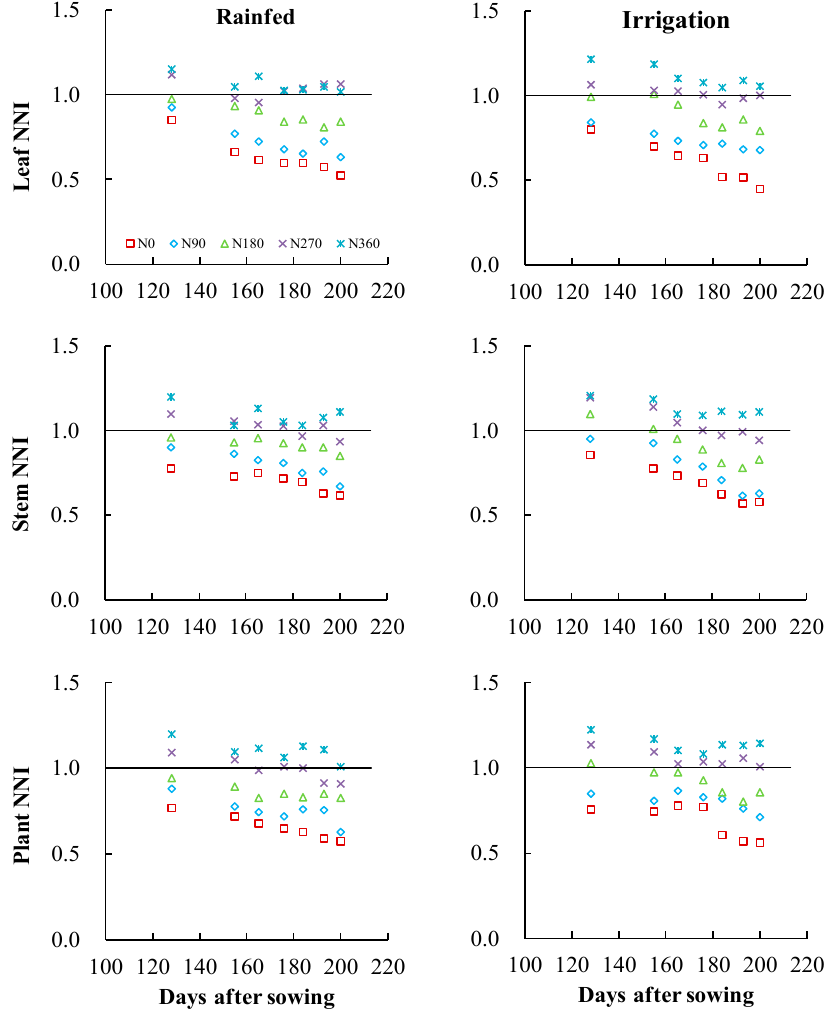
Figure 6. Effects of N application rates on the N nutrition index (NNI) of wheat under different Figure 6. E ff ects of N application rates on the N nutrition index (NNI) of wheat under di ff erent irrigation conditions in Zhengzhou. The datasets are from Exp. 2. irrigation conditions in Zhengzhou. The datasets are from Exp.